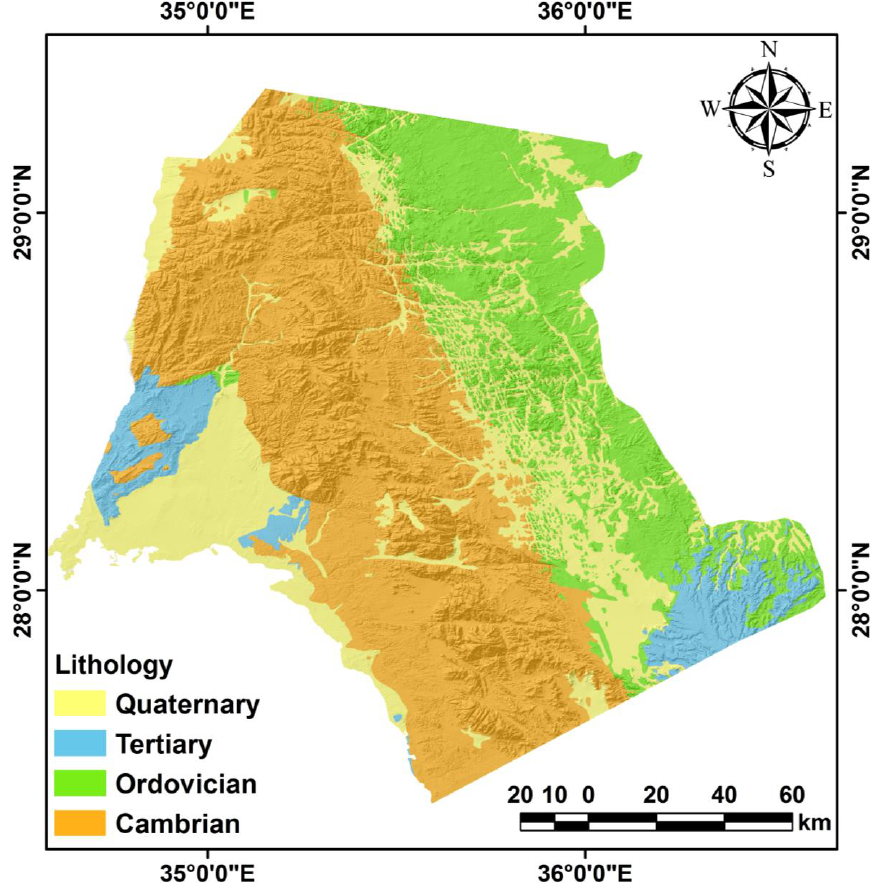
Figure 2. Map showing the main types of rocks in Neom, which are igneous and metamorphic rocks from the Precambrian period, as well as sedimentary rocks from the Tertiary and Quaternary peri- ods.